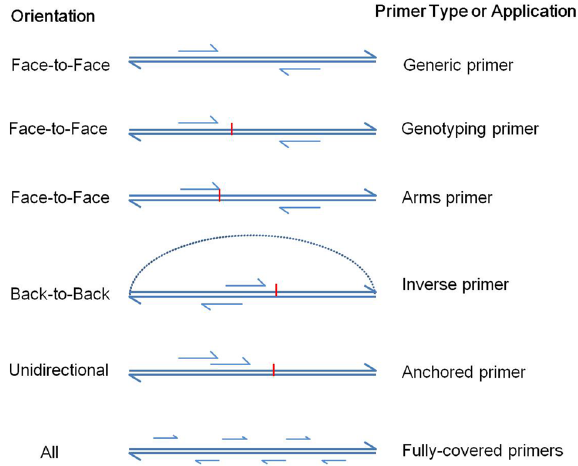
Figure 1. Orientations and types of primers that can be designed using PrimerScore2. The red vertical bars indicate targets (SNPs, insertions, deletions, or targeted